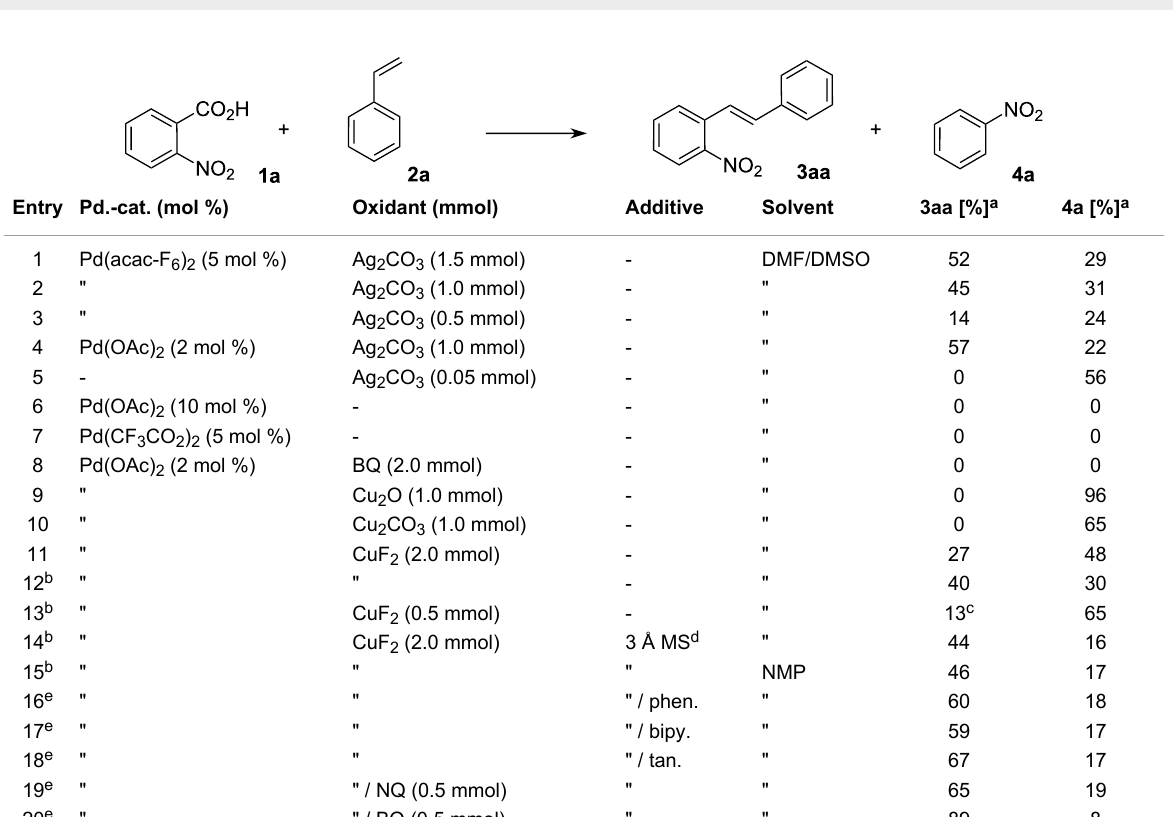
Table 1: Reaction of 2-nitrobenzoic acid with styrene.